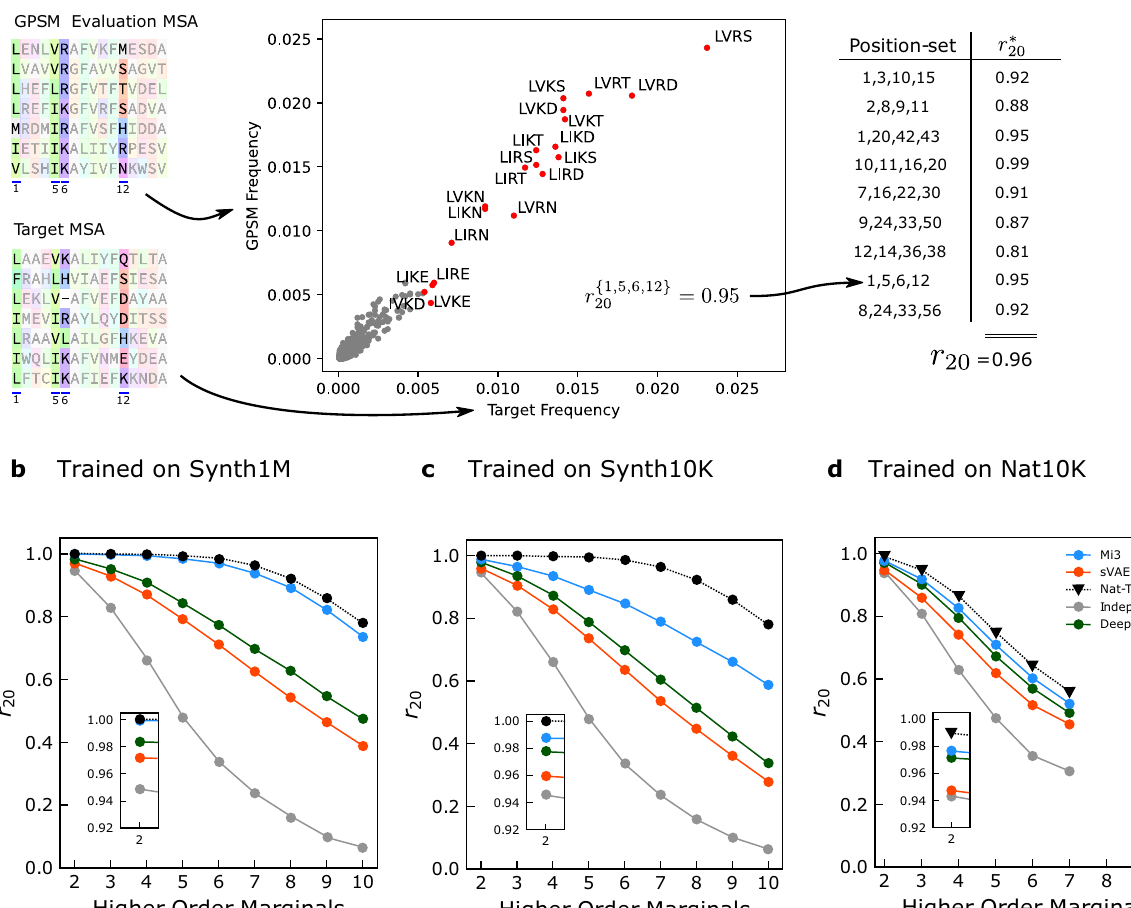
Fig. 3 Ability of GPSMs to capture higher-order covariation ( r 20 ). a Diagram of r 20 calculation for n = 4. Left: For a particular set of positions, {1, 5, 6, 12} in this case, the subsequence frequencies for all words at these positions is calculated for the target MSA and the evaluation MSA. Middle: The word frequencies for the two MSAs are compared, and the top-20 most frequent words according to the target MSA (red points, labeled by word) are used to compute the Pearson- r value between the two sets of values. Right: This procedure is repeated for many different position-sets. The fi nal r 20 score is the average of the r across position-sets. Bottom row: Pearson r 20 score ( y -axis) as a function of Higher-Order-Marginal (HOM) word length ( x -axis), illustrating how well each GPSM predict HOMs from the target probability distribution. GPSMs were trained on 1M synthetic (Synth1M, b ), 10K synthetic (Synth10K, c ), or 10K natural (Nat10K, d ) sequences from the corresponding target probability distribution. r 20 scores for each GPSM are computed using GPSM-generated evaluation MSAs of 6M sequences compared to target MSAs of 6M sequences for the synthetic tests ( b , c ) or to a target MSA of 10K natural sequences for the natural test ( d ) due to limited natural sequence data. The black dotted line denotes the upper bound for r 20 due to estimation error given the evaluation MSA size of 6M for the synthetic analysis and 10K for the natural analysis. This re fl ects the expected value if the GPSM had modeled p 0 ( S ) exactly given these MSA sizes. It must be approximated for the natural test as signi fi ed using triangle markers (see text for detail). For panel d , only lengths 2 through 7 are plotted, as the small dataset size limits HOM estimation. Insets emphasize pairwise r 20 . Comparing panels c and d , it appears that the generative capacity of Mi3 and the VAEs are sensitive to decreasing synthetic training sample size for r 20 , whereas Indep is